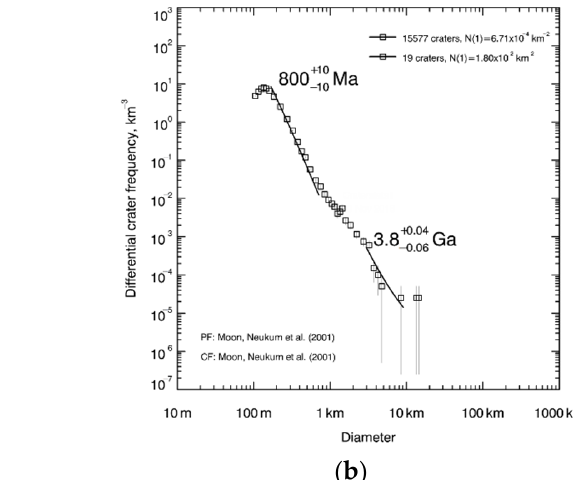
Figure 7. Copernicus ejecta CSFD dating. (a) Primary craters (red) and secondary craters (yellow) in the intersection of the Copernicus ejecta; (b) Differential crater frequency and geologic time of the Copernicus ejecta.